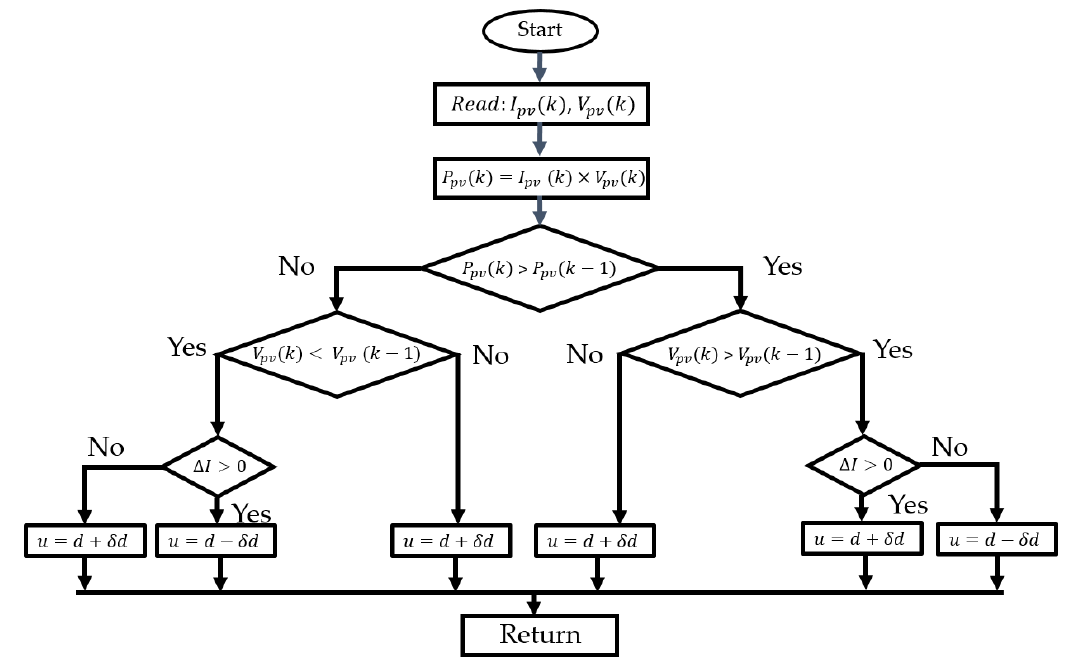
Figure 7. Flowchart of Drift-free